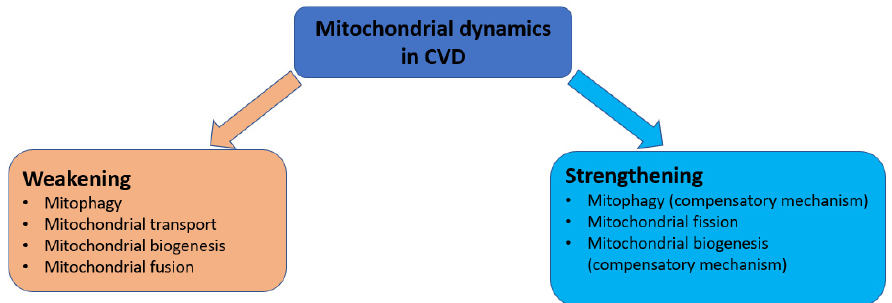
Figure 3. Mitochondrial dynamics disorders in cardiovascular diseases.